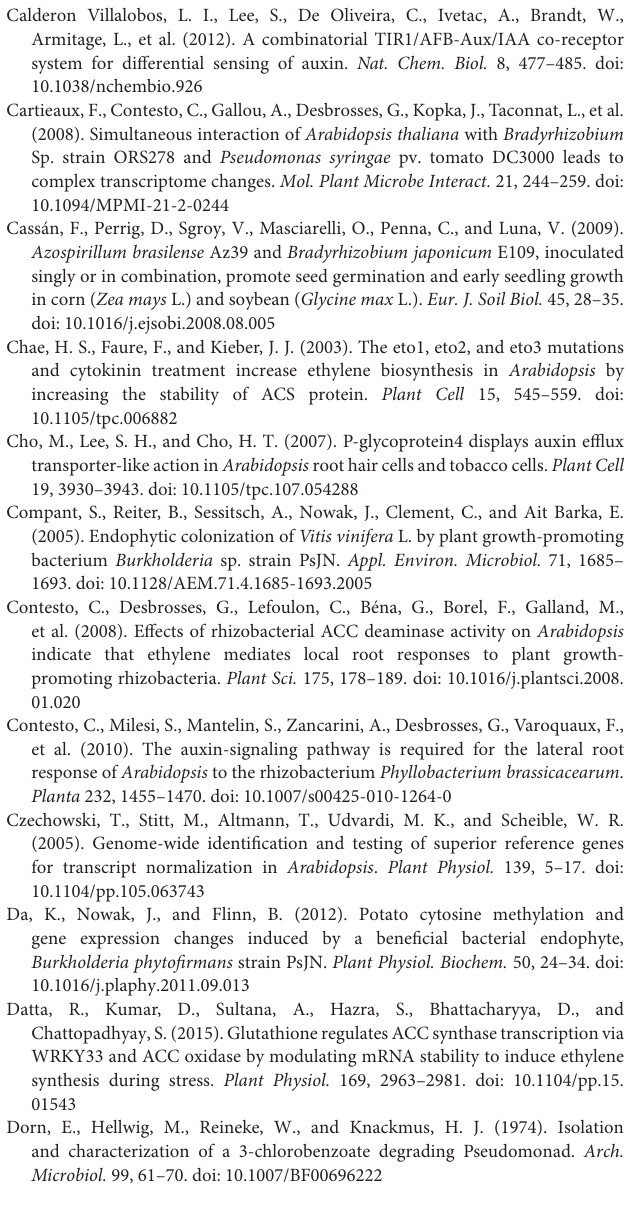
FIGURE S1 | Effects of Burkholderia phytofirmans PsJN in root hair number and length in the eir1–1 and eto2 mutants. Graphic representation of the root hair number and hair length of root tips (5 mm) from eir1–1 (A) and eto2 mutants inoculated (PsJN) or not (Control) with B. phytofirmans PsJN. Data are means ± SE of at least 20 plants per treatment. Asterisk indicates statistical significance between the inoculated and non-inoculated plants in each genotype (Kruskal–Wallis non-parametric test, p < 0.05). TABLE S1 | List of real time RT-PCR primers. Melting temperatures, amplicon sizes and references, if applicable, are